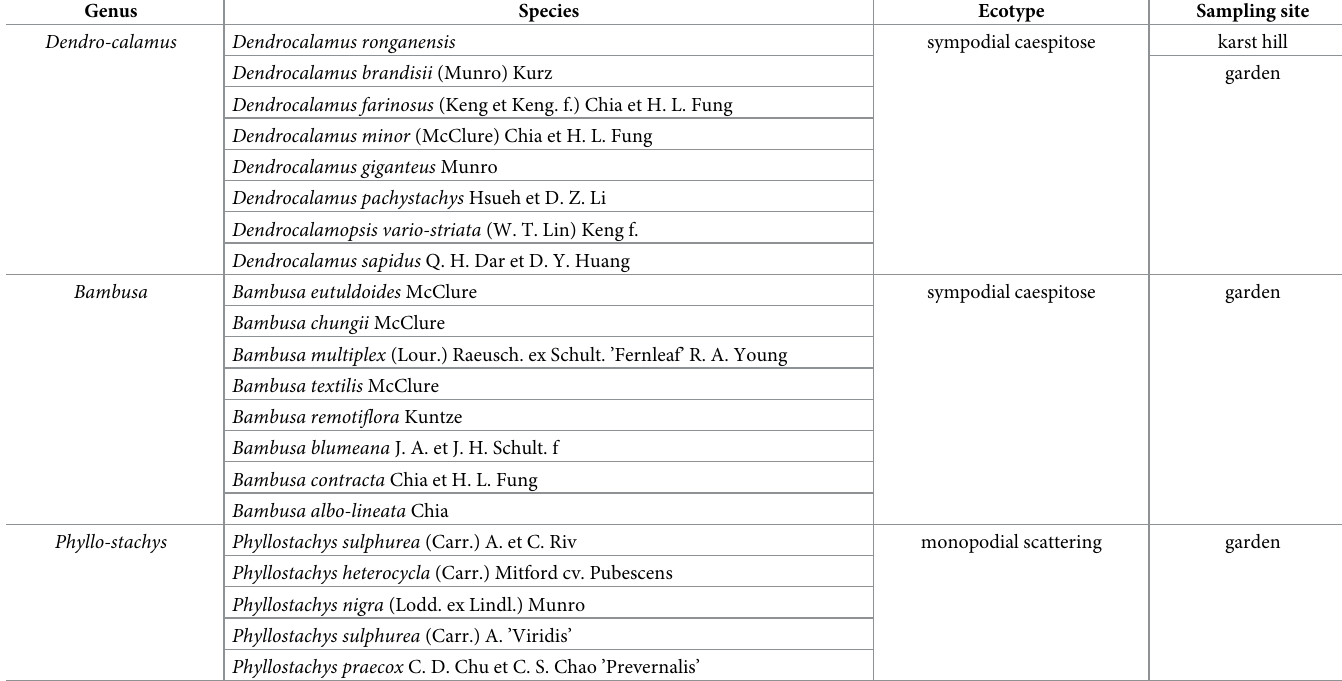
Table 1. Sampling information.